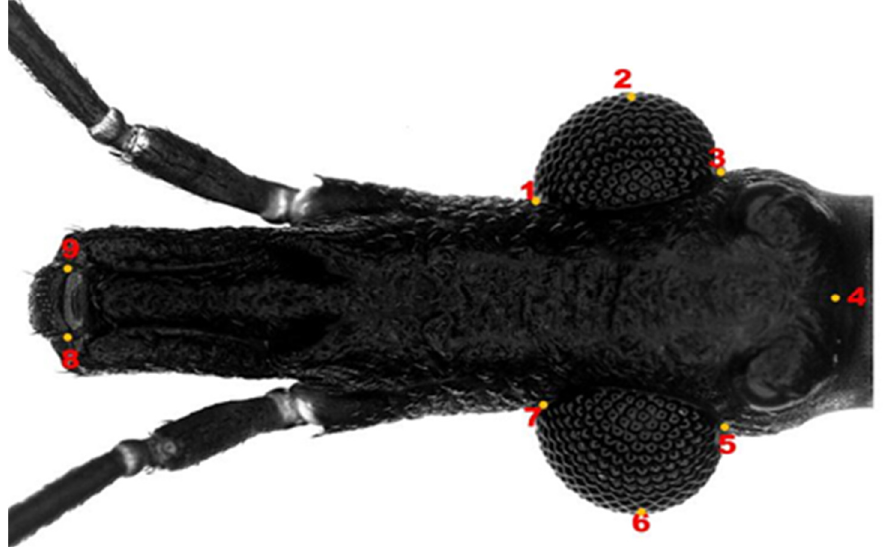
Figure 2. Image of the head of an adult male of T. infestans , with marking of the nine type II anatomical landmarks, which were used as coordinates. 1 – 3 : Eye region; 4 : Head size; 5 – 7 Eye region; 8 – 9 Clypeus region.